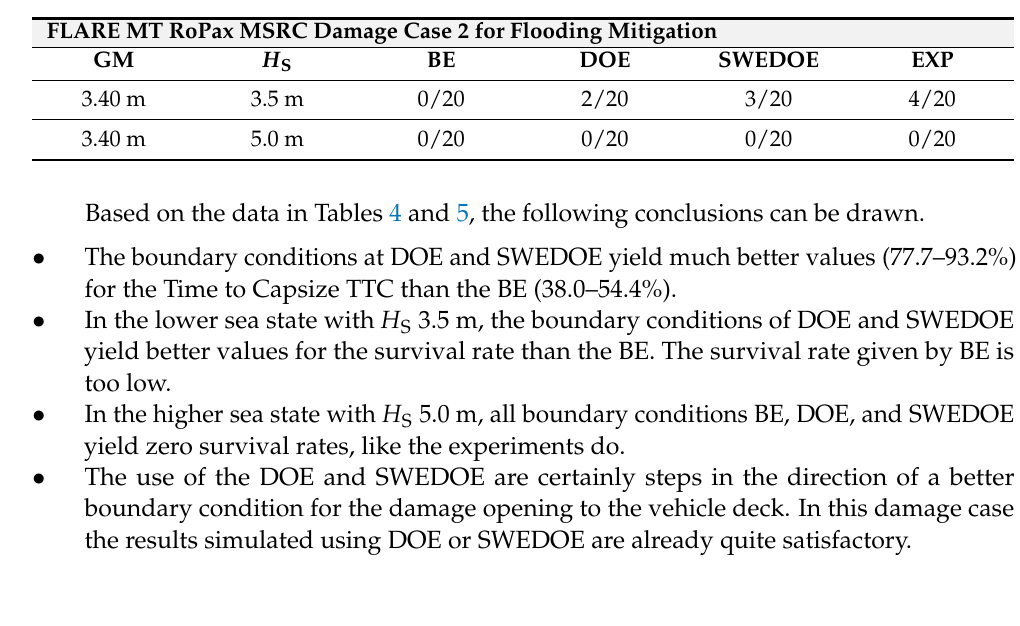
Table 5. Computed Survival rates in comparison with experimental